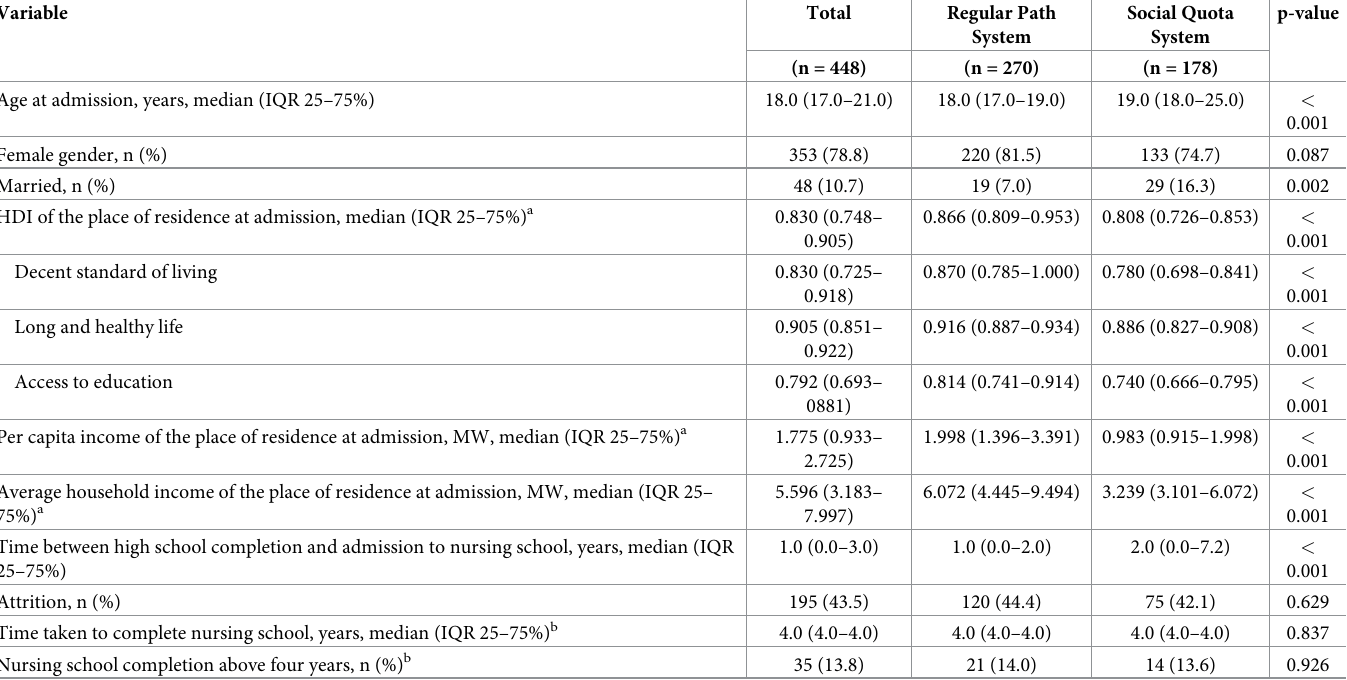
Table 1. Univariate analysis comparing students admitted to nursing school at the School of Health Sciences (ESCS), Brası´lia, Federal District, Brazil, from the reg- ular path and social quota systems between 2009 and 2014 (n = 448). Variable Total Regular Path